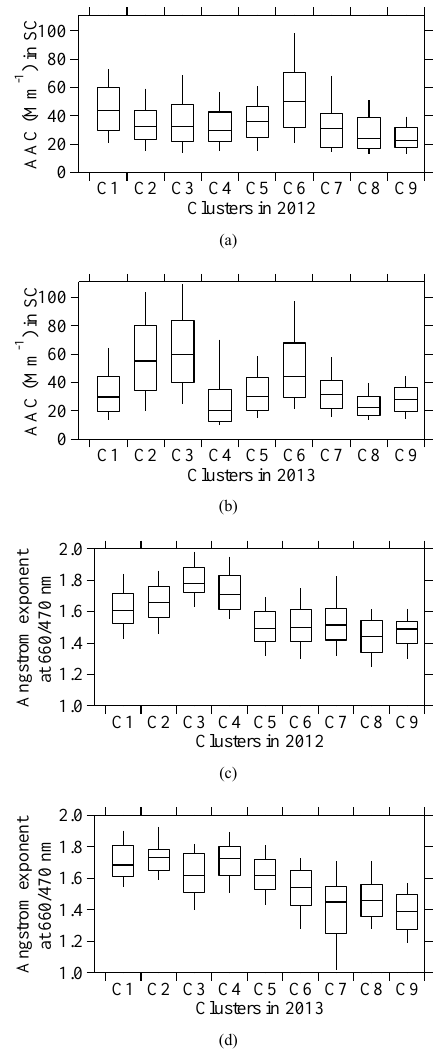
Figure 9. The 10, 25, 50, 75, and 90% percentile values of the aerosol absorption coefficient (a, b) and absorption Ångström ex- ponent (c, d) in each cluster of back trajectories in 2012 (Fig. 8a) and 2013 (Fig.